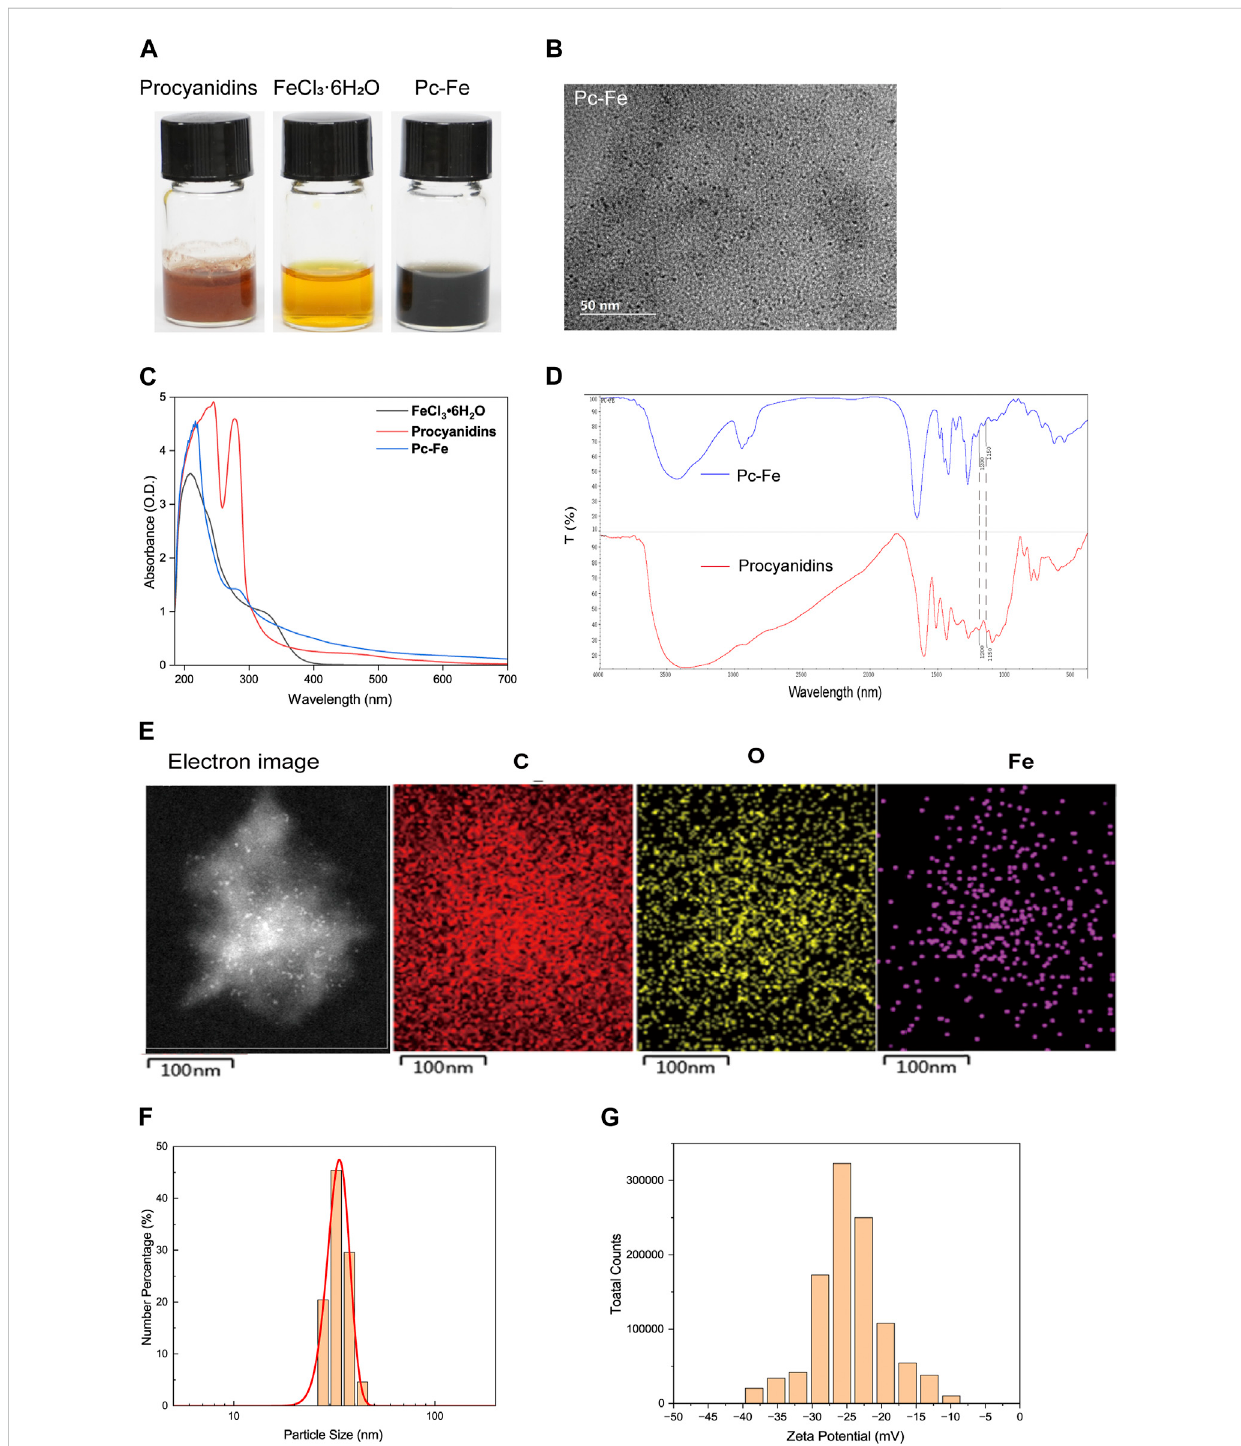
FIGURE 2 Synthesis and characterizations of Pc-Fe. (A) Physical drawing of Pc-Fe at room temperature for 7 days. (B) TEM images of Pc-Fe. (C) The UV-vis